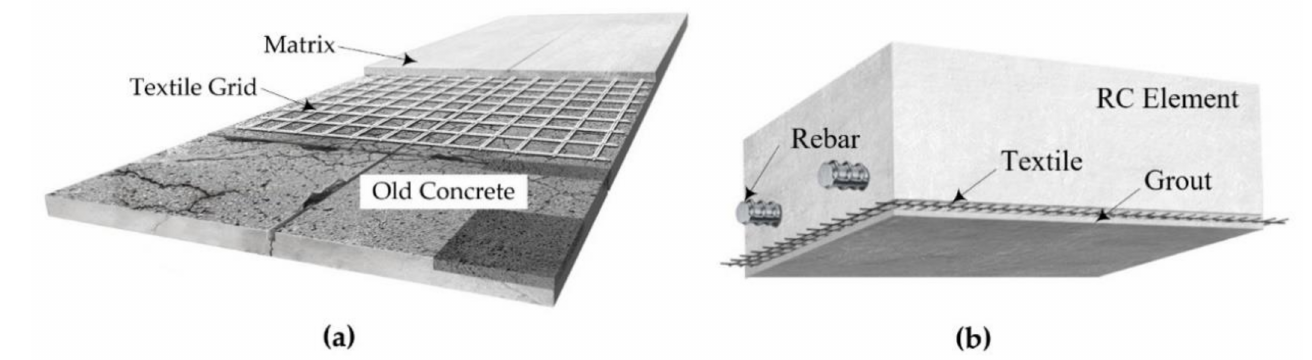
Figure 1. TRC-strengthening methods for concrete elements: ( a ) overlay method; ( b ) proposed